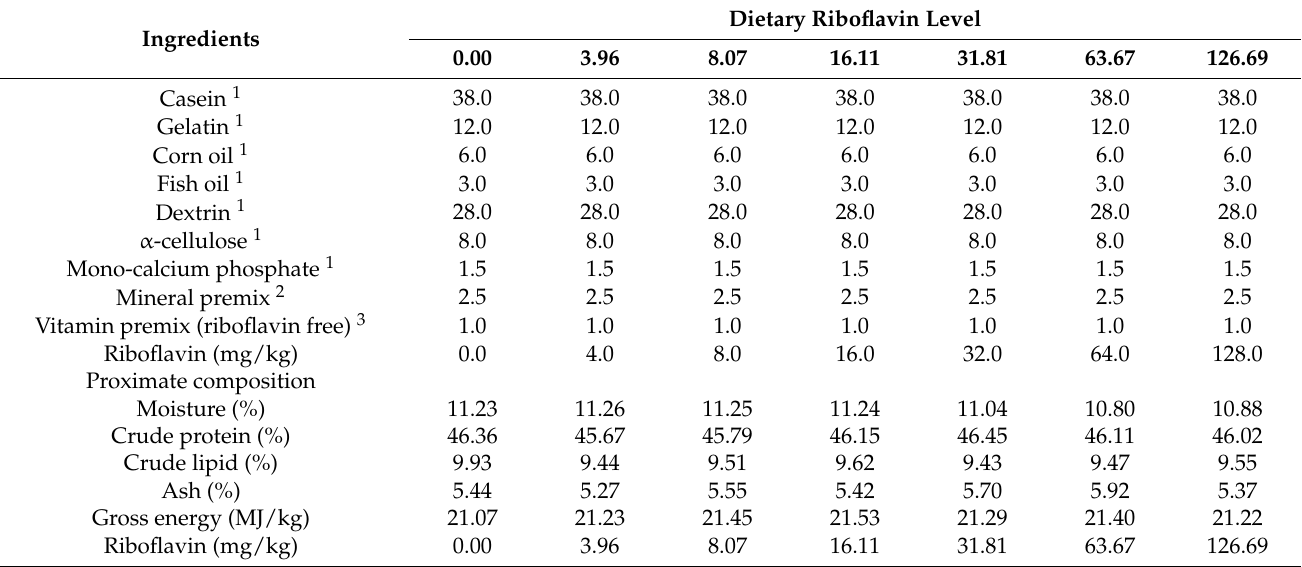
Table 1. Formulation and proximate composition of the experimental diets for coho salmon ( On- corhynchus kisutch ) post-smolts (% dry